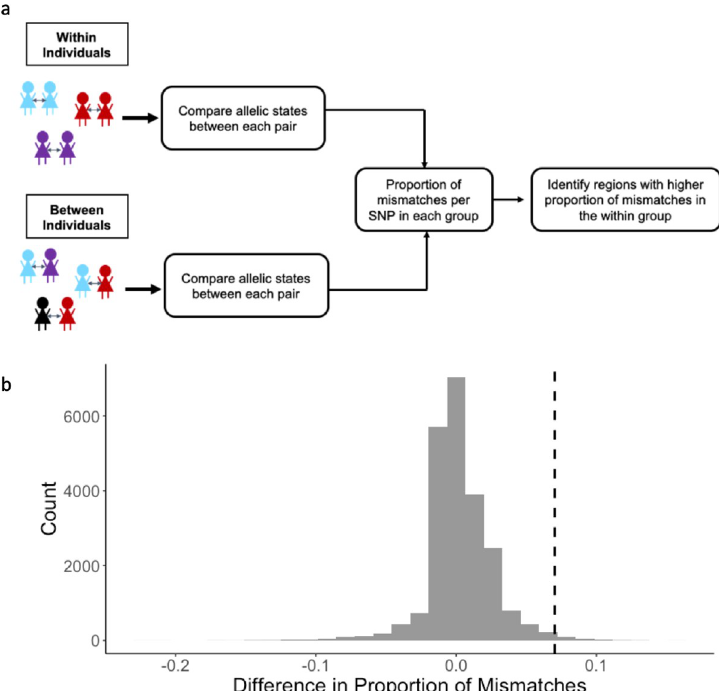
Fig 3. Analysis of mismatches in paired samples within and between individuals. a) Illustration of analysis to identify regions of the genome that vary more in parasites causing illness within the same individual over time (within individuals) compared to random pairs of parasites in the population (between individuals). b) Distribution of differences in the proportion of mismatched alleles in the within group and the between group. The difference was calculated as the proportion of mismatches at each non-synonymous SNP in the within group minus the proportion of mismatches at each non-synonymous SNP in the between group. The dashed black line indicates the threshold for the top 1% most different SNPs in the within group compared to the between